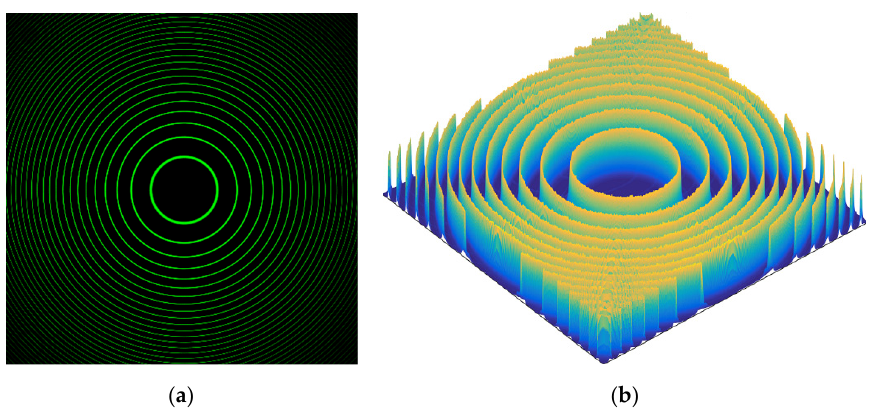
Figure 9. Concentric interference ring image from experimental setup: ( a ) high-brightness concen- tric interference ring image and ( b ) the 3D image of the light intensity signal of the concentric inter- ference ring.